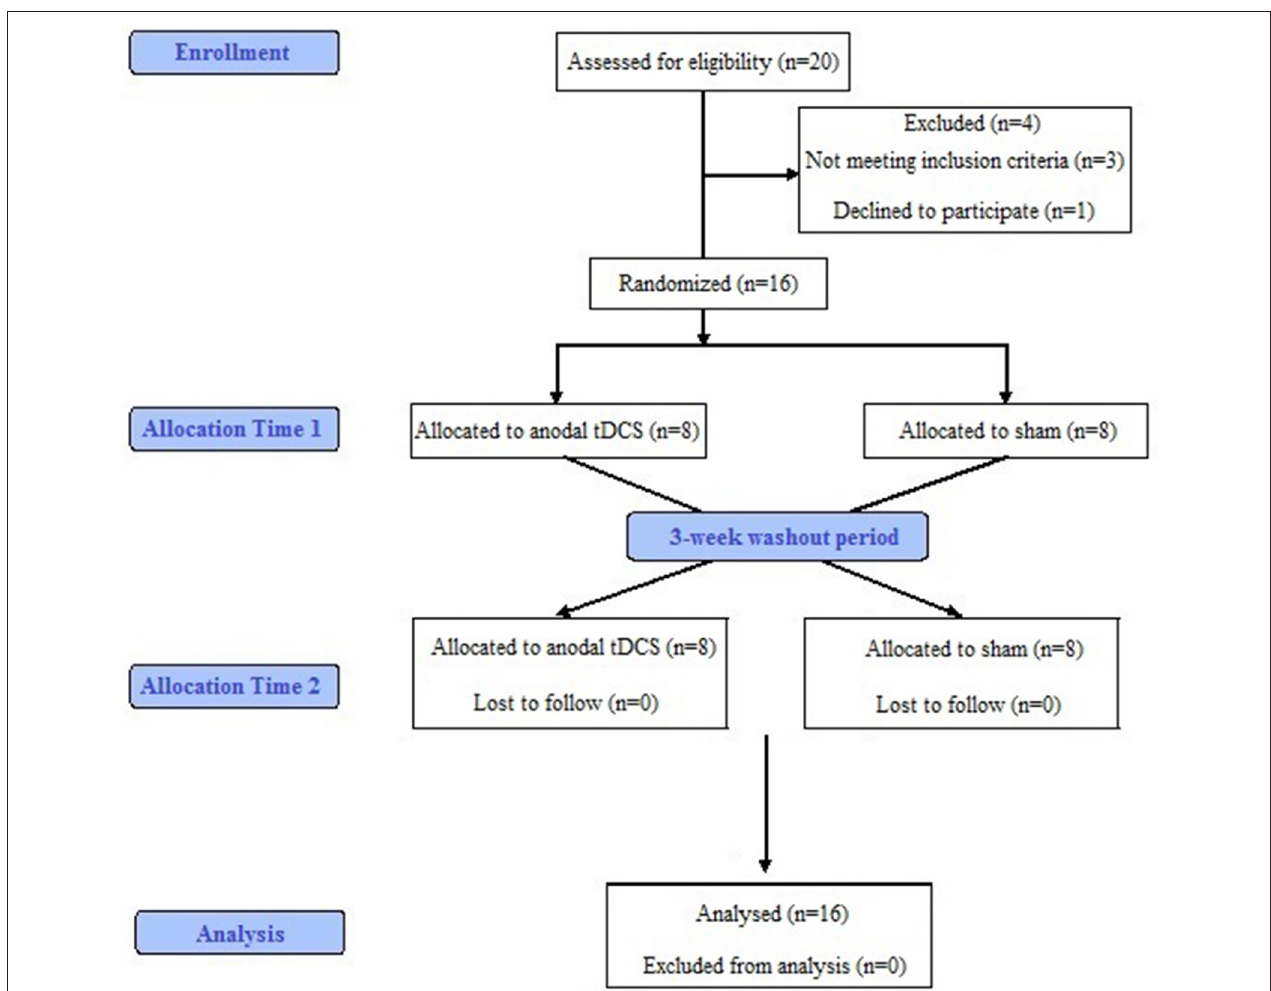
FIGURE 4 | Schematic flow chart of patients through the